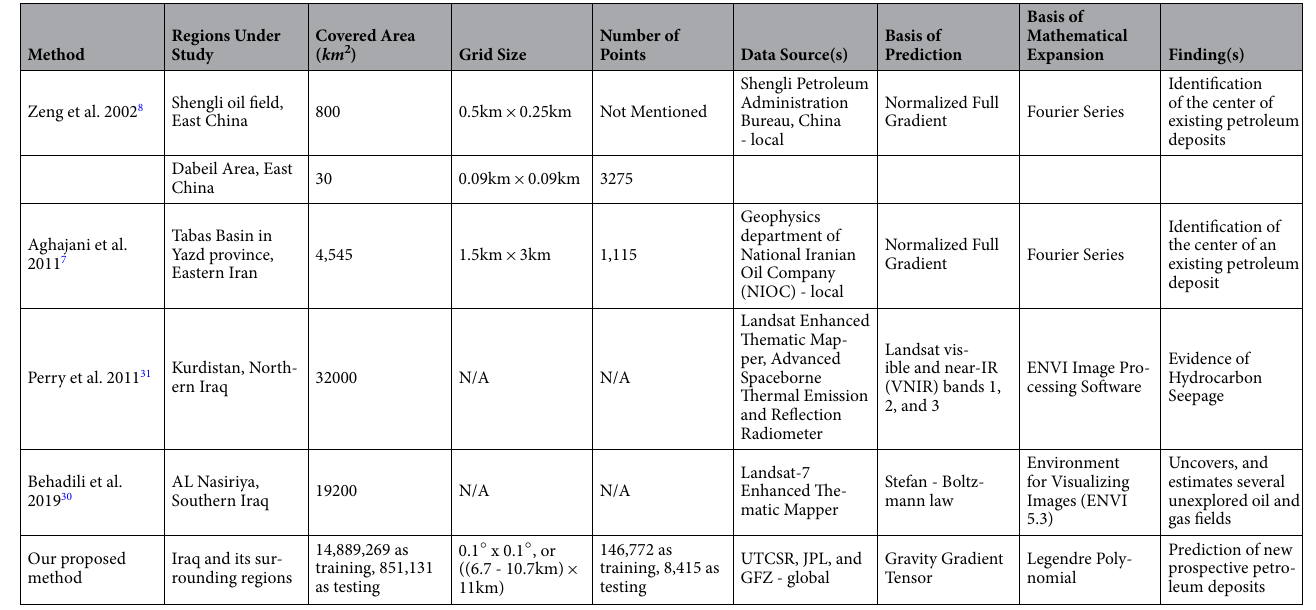
Table 8. Comparison between our proposed method with other existing related research studies.